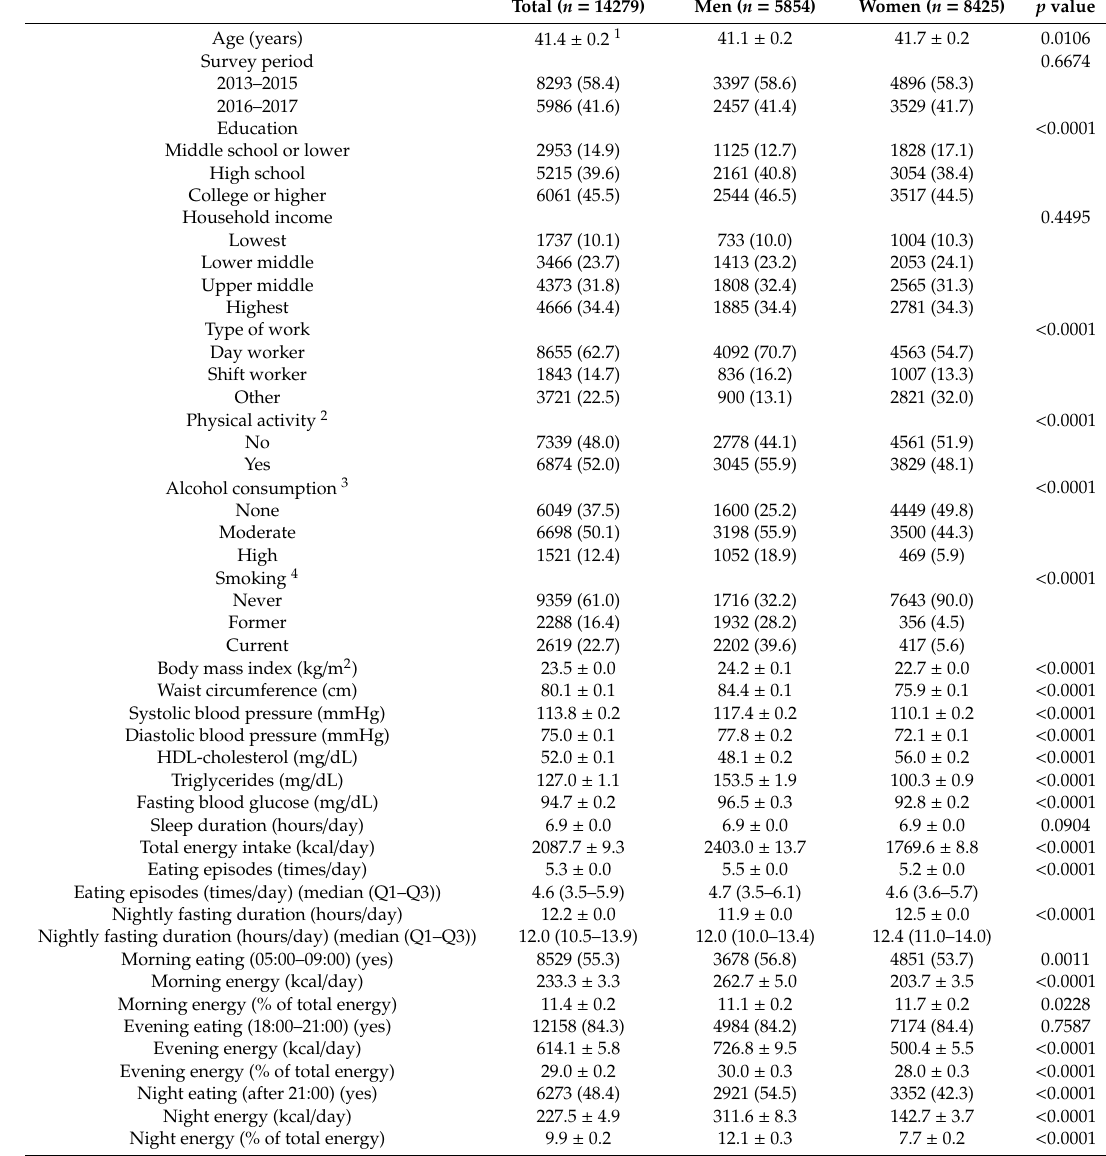
Table 1. General characteristics of the study